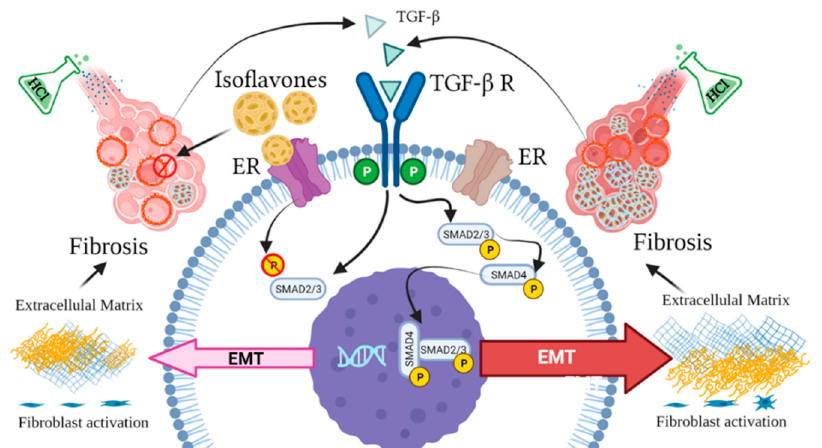
Figure 8. Estrogen-dependent signaling pathways mediating HCl-induced pulmonary fibrosis. Dietary phytoestrogen isoflavones modulate alveolar inflammation and block TGF- β SMAD signaling through activation of estrogen receptor (ER), preventing fibroblast activation and overexpression of extracellular matrix.